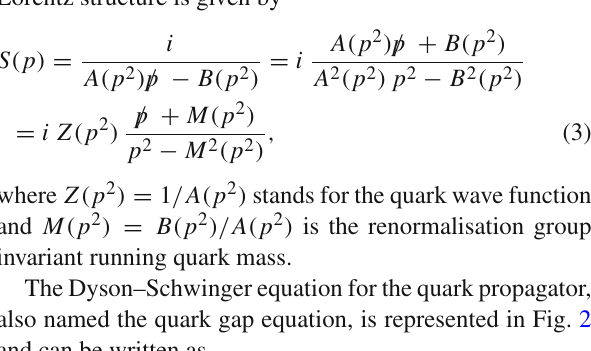
Fig. 1 The quark-gluon vertex